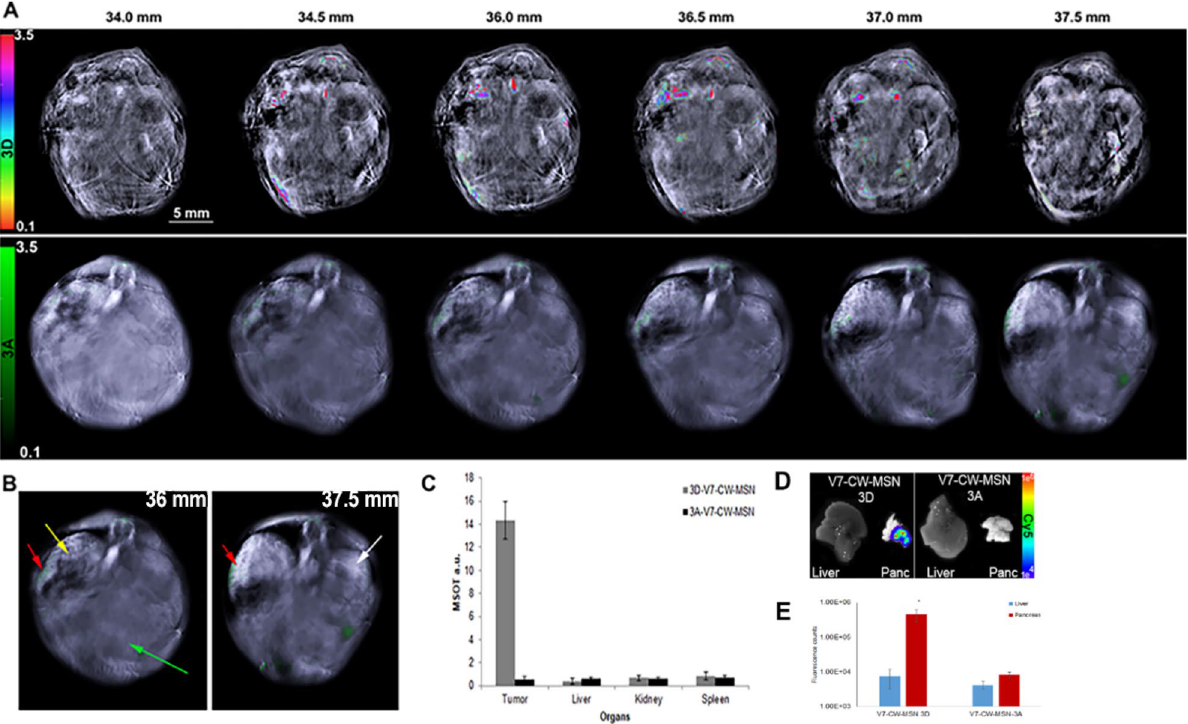
Figure 5. Serial slices (transverse) showing nanoparticle accumulation in orthotopic pancreatic tumor bearing athymic mice. Mice were IV tail-vein injected with 100 µL of V7-CW-MSN at a concentration of 5 μg/mL loaded with either 3A or 3D . The concentration of dye was balanced via an OD of 0.1 dye encapsulated within the V7-CW-MSN . 0.1 OD corresponds to a dye 3A concentration of 150 μg/mL (132 million 3A molecules per particle) and a 3D concentration of 17.5 μg/mL (18 million 3D molecules per particle). Injected mice were imaged at an early time point of 4 h post-injection. Serial cross section of mice injected with 3A V7-CW-MSN (bottom) or 3D V7-CW-MSN (top) are presented together for comparison. Mean tumor size was 3 mm. ( A ) This image shows serial slices of mice injected with 3A V7-CW-MSN (bottom) or 3D V7-CW-MSN